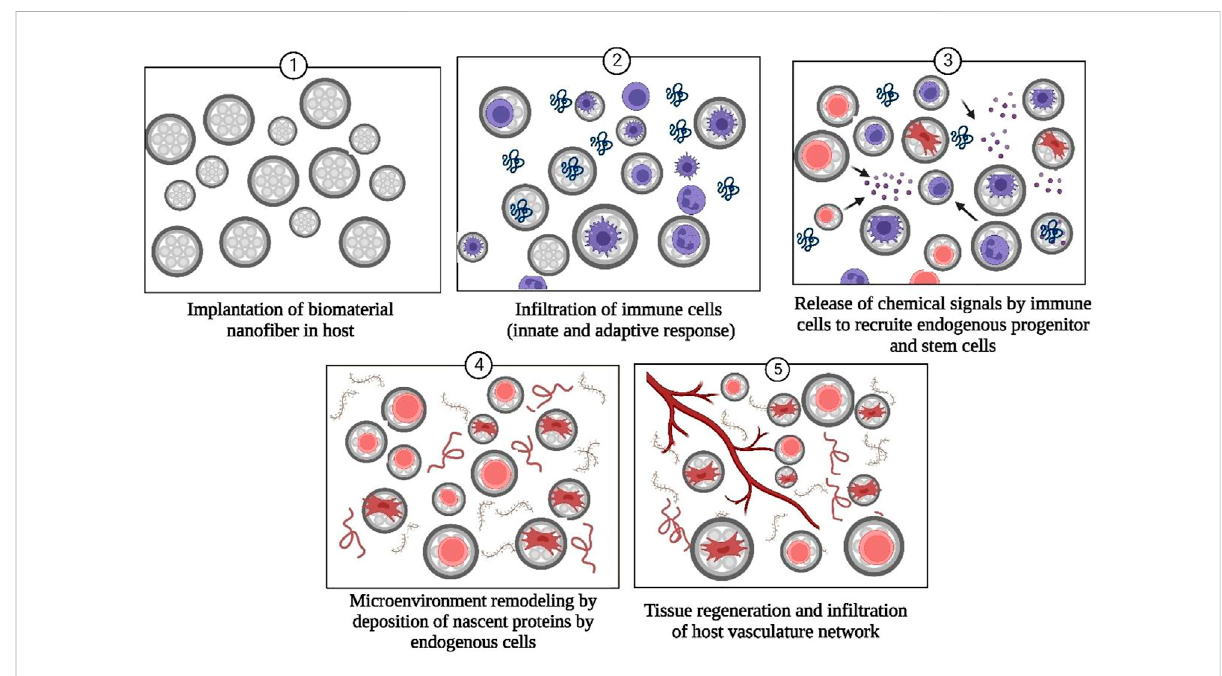
FIGURE 4 Mode of action of HA-based nano fi ber scaffolds for tissue